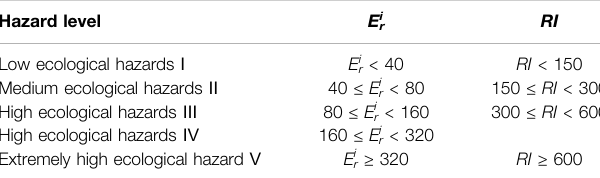
TABLE 4 | Relationship between E i r and RI and